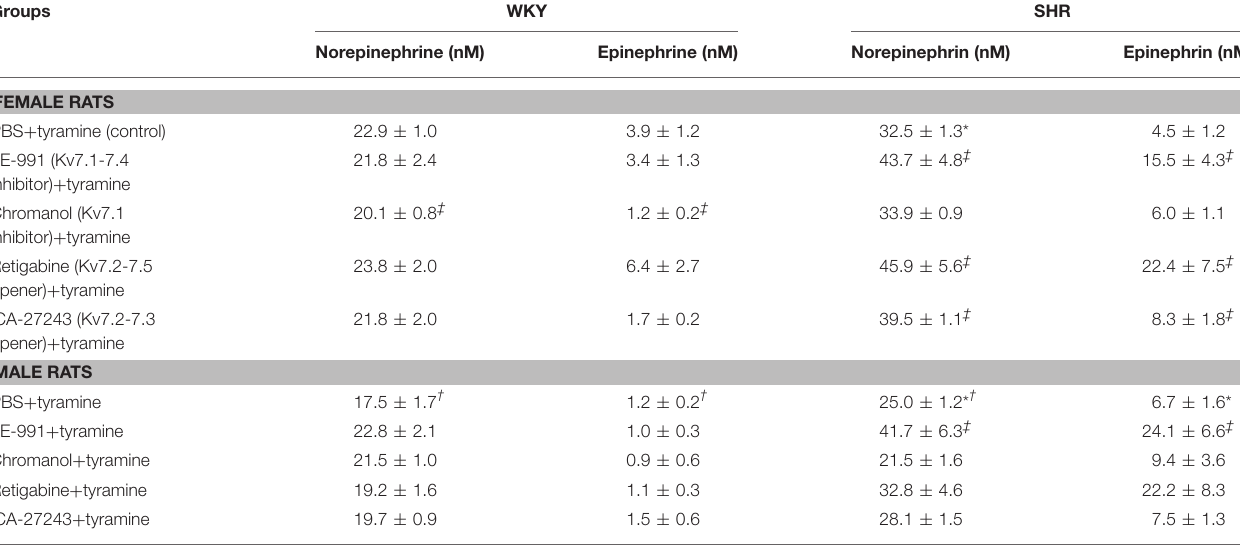
TABLE 1 | The effect of Kv7 inhibitors/openers on the plasma catecholamine concentrations after tyramine-stimulated norepinephrine release.